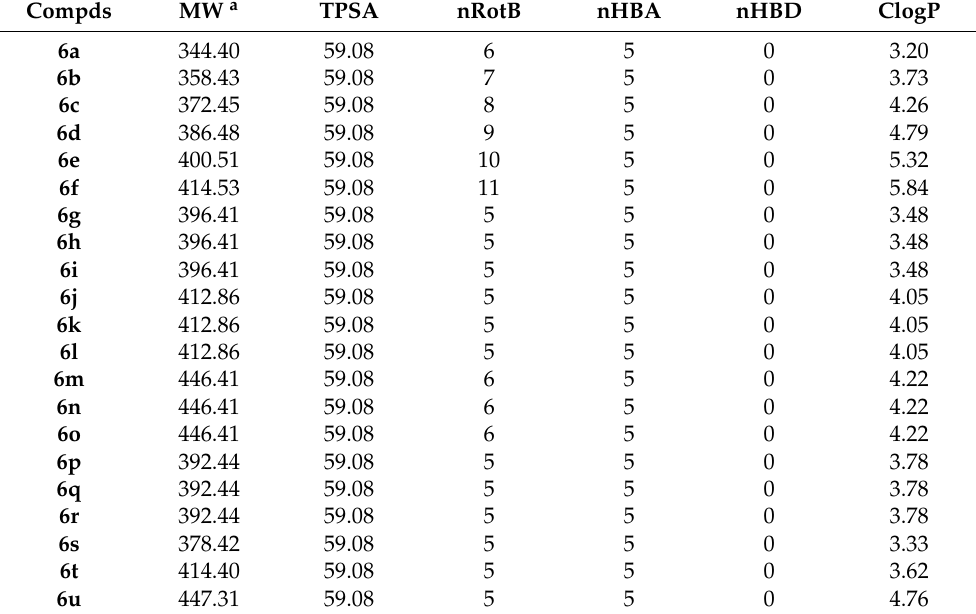
Table 2. Drug-likeness parameters of target